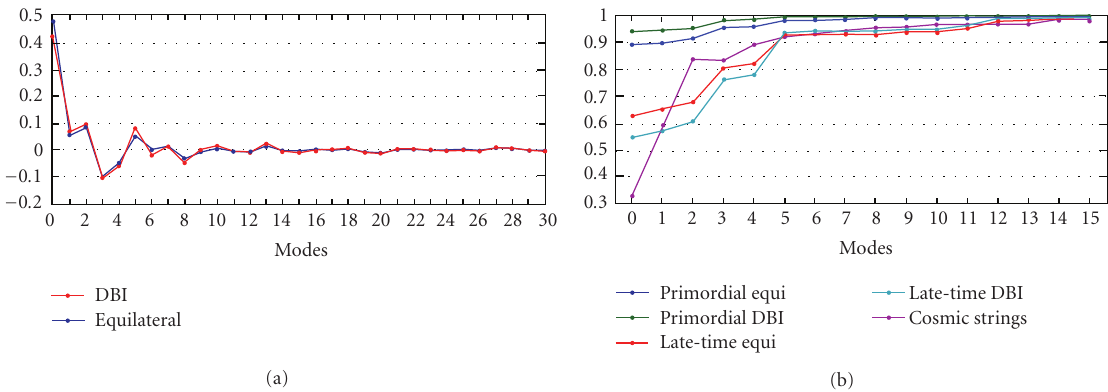
Figure 5: Orthonormal eigenmode decomposition coe ffi cients (26) for the equilateral and DBI models (a) and shape correlations (19) of the original bispectrum against the partial sum up to a given mode n (b). The correlation plot includes both primordial and late-time CMB bispectra for the equilateral and DBI models, as well as the late-time CMB bispectrum from cosmic strings (refer to Section 3). In all cases, we find that we need at most 15 three-dimensional modes to obtain a correlation greater than 98% (primordial convergence without the acoustic peaks requires only 6 modes). Table 2: Shape correlations (19) and CMB correlations (61) for 5 distinct families of primordial non-Gaussian models. Local Warm Flat